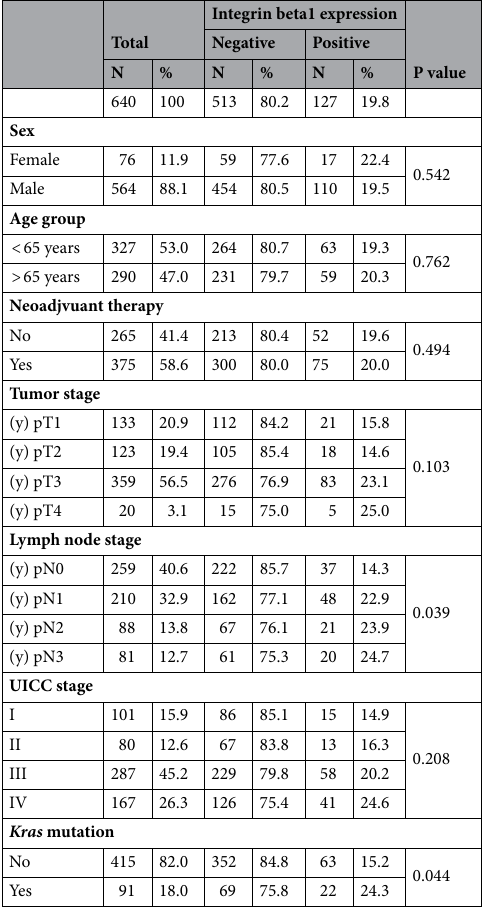
Table 1. Clinico-pathological data of the entire patient